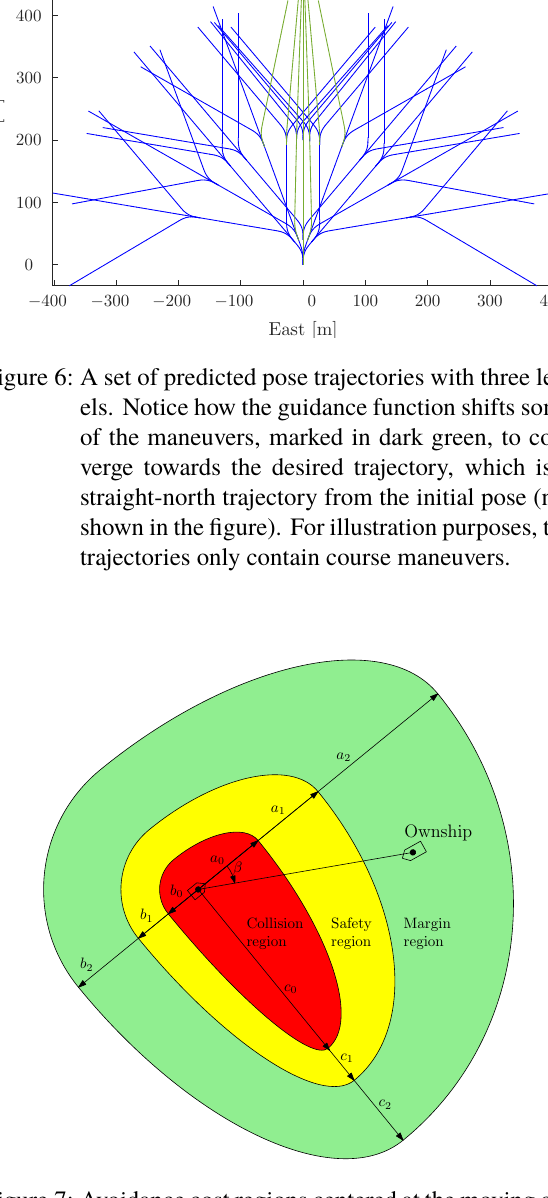
Figure 7: Avoidance cost regions centered at the moving ob- stacle, each constructed by one circular and three elliptical segments. The green, yellow and red regions are named the margin, safety and colli- sion regions, respectively. The avoidance cost in- creases linearly with different gradients inside the green and yellow regions, while the cost is con- stant inside the red region. The variables 𝑎 , 𝑏 𝑖 𝑖 and 𝑐 , 𝑖 ∈ { 1 , 2 , 3 } denote the region sizes, where 𝑖 with 𝑑 controlling the 𝑐 𝑏 𝑑 COLREGs COLREGs 𝑖 = 𝑖 + COLREGs expansion. Courtesy of (Eriksen et al.,